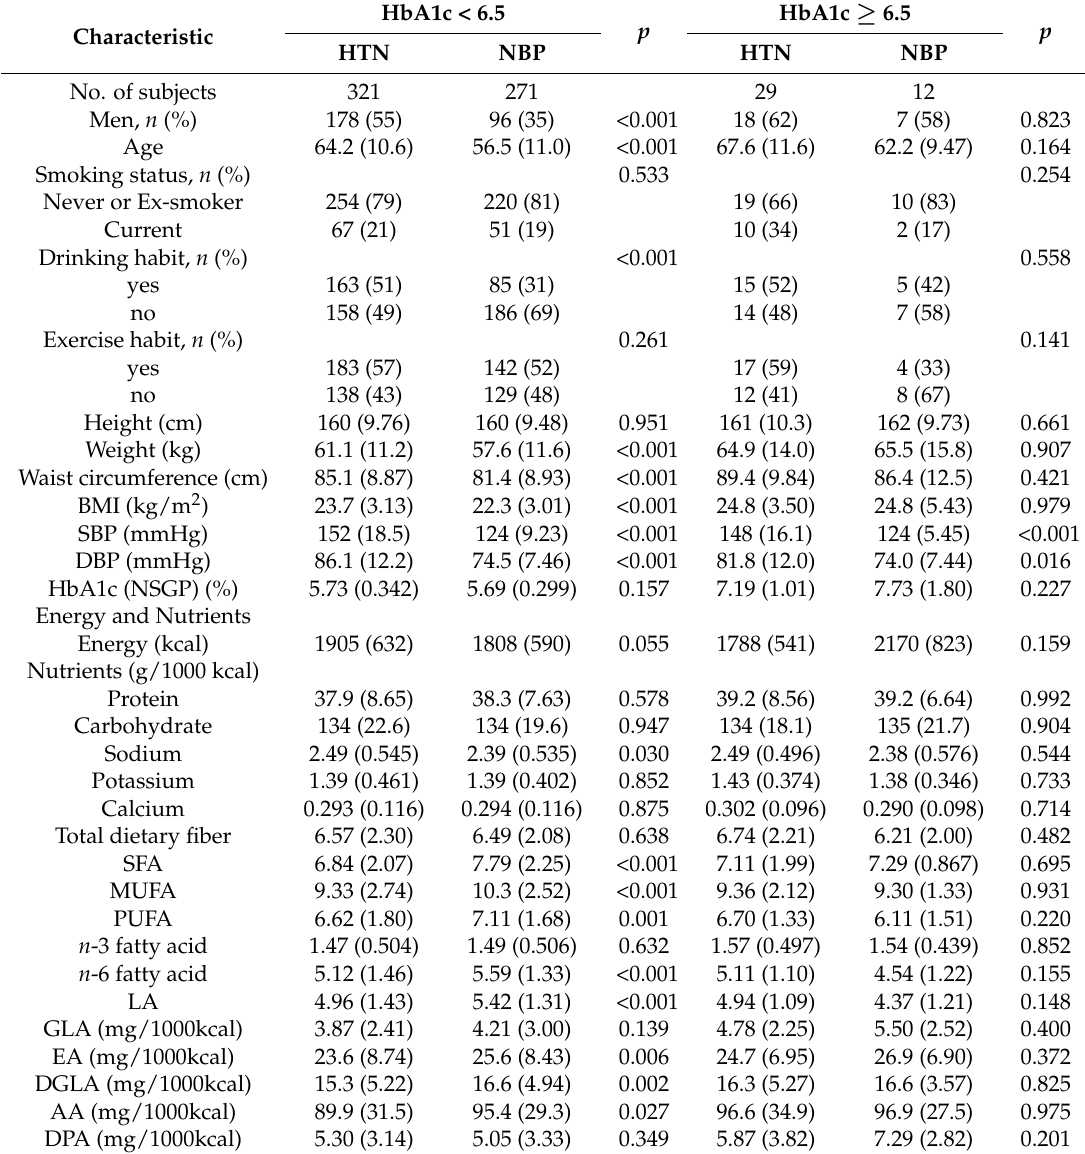
Table 4. Participant characteristics in different blood pressure groups according to HbA1c